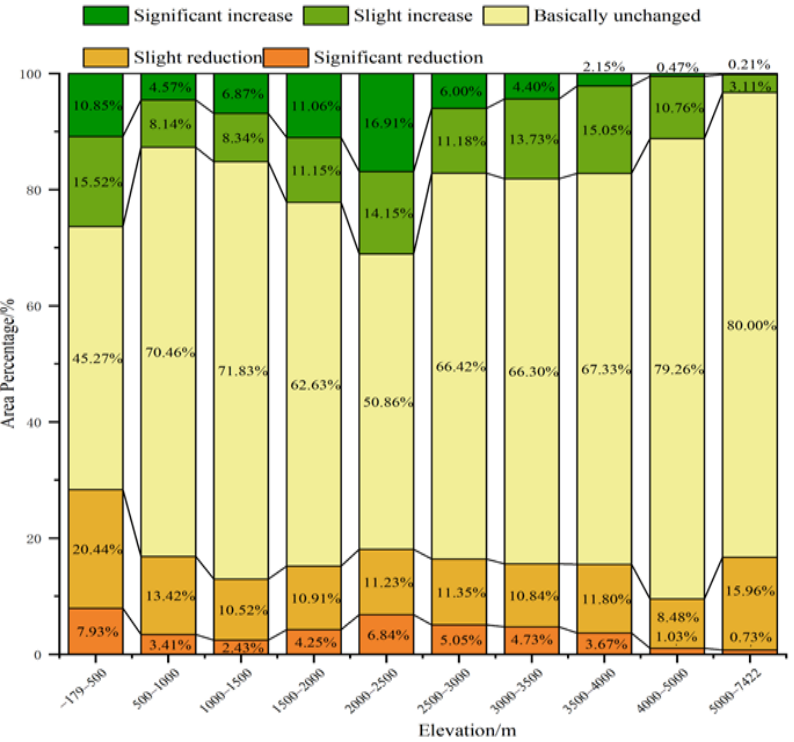
Figure 11. Vegetation cover change statistics at different elevations in the Three North Protection Forest Project area.